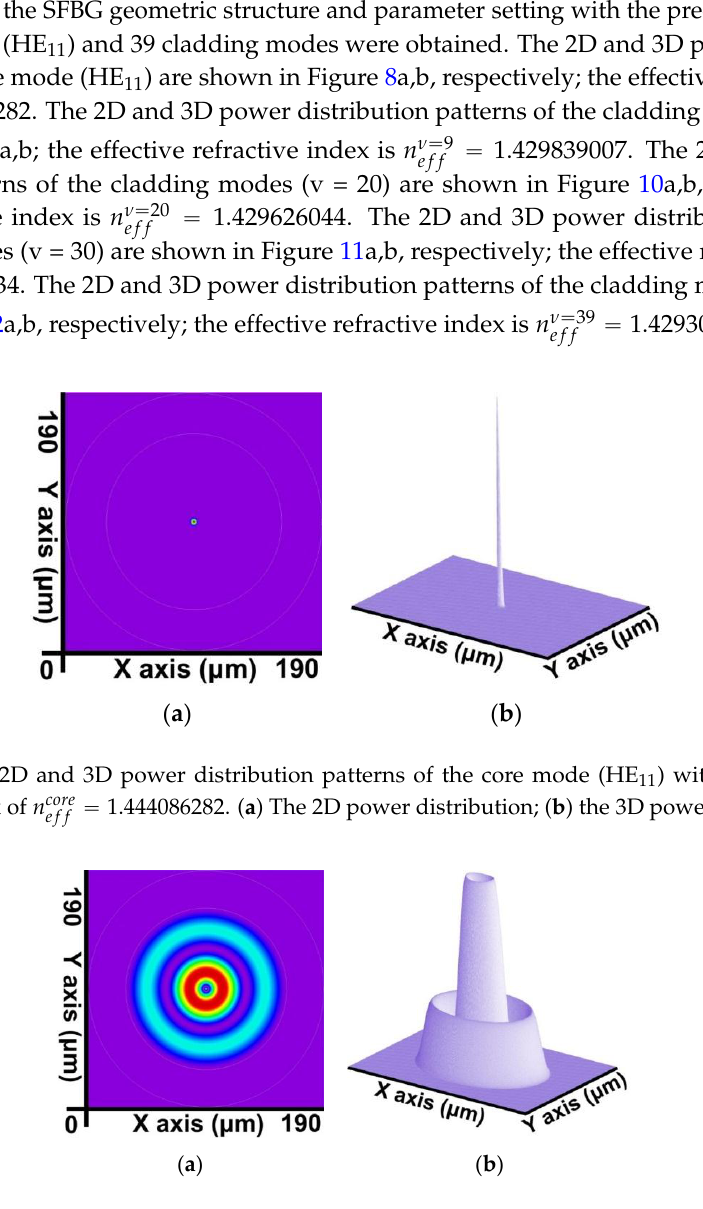
Figure 9. The 2D and 3D power distribution patterns of the cladding modes (v = 9) with an effective refractive index of 71.42983900 9 eff n . ( a ) The 2D power distribution; ( b ) the 3D power distribution.